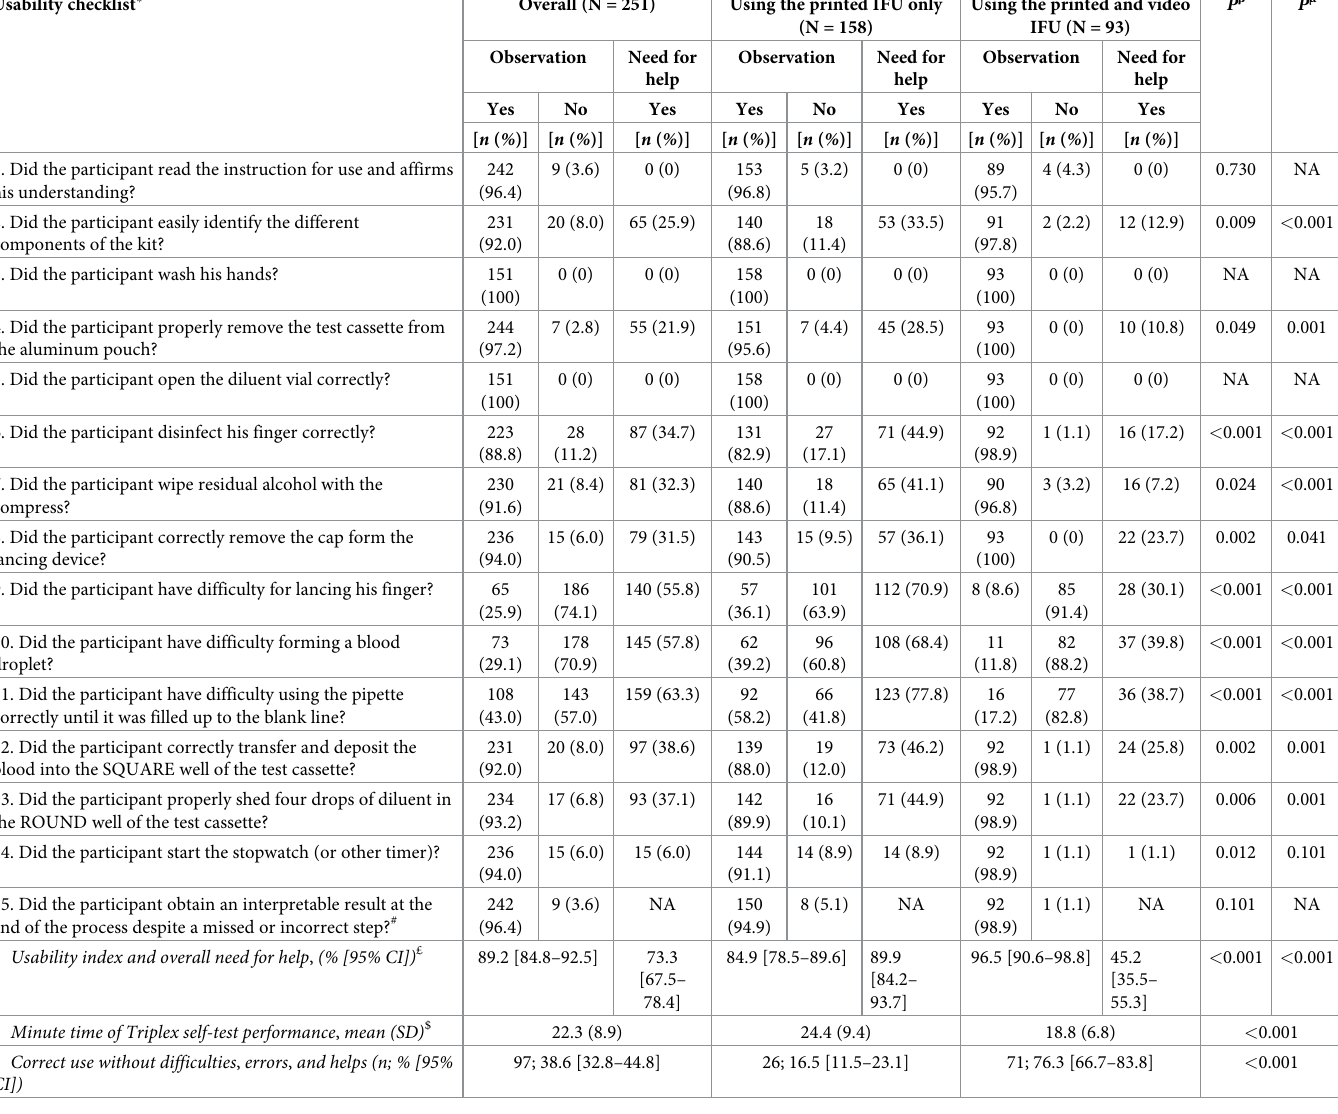
Table 2. Analytical results of the observation concerning the ability of the 251 study participants to correctly use each step of the Triplex HIV/HCV/HBsAg self- test autonomously or with verbal help using the printed instruction for use versus the combination of printed and video instructions for use (substudy 1). Usability checklist